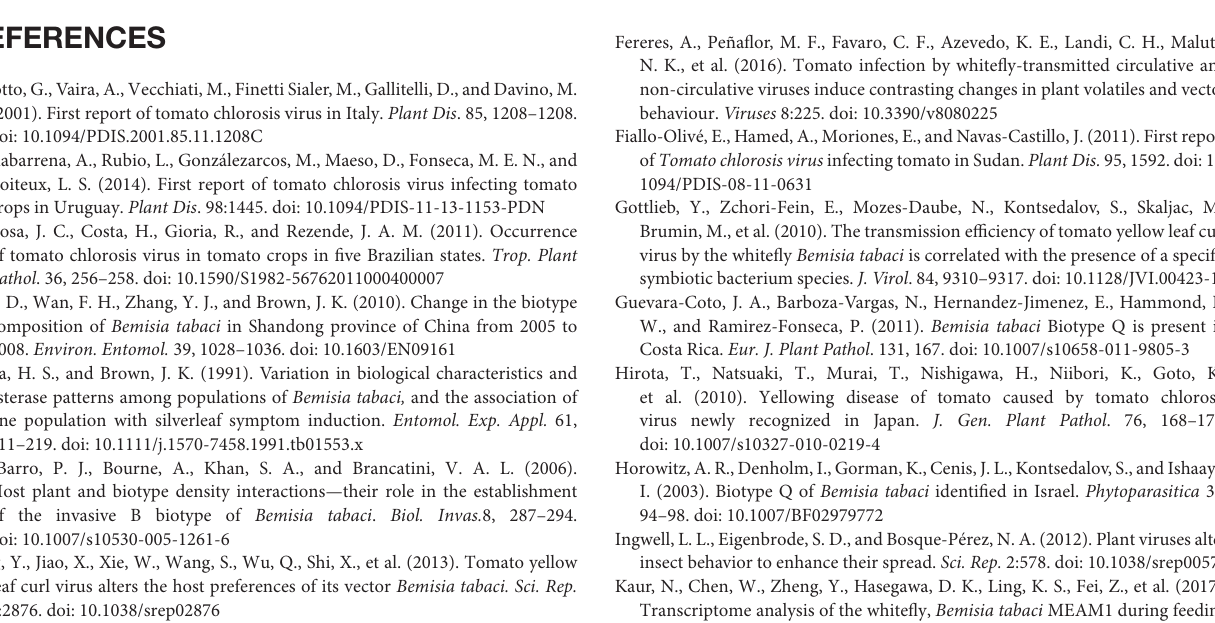
Supplementary Figure 1 | Sample collection in retention of tomato chlorosis virus. There were seven time periods: 0, 6, 12, 24, 48, 72, and 96h. At each time point, 12 clip-cages with 3 clip-cages of MEAM1 female, 3 cages of MEAM1 male, 3 cages of MED female, and 3 cages of MED male were collected. A total of 84 clip-cages were collected in this